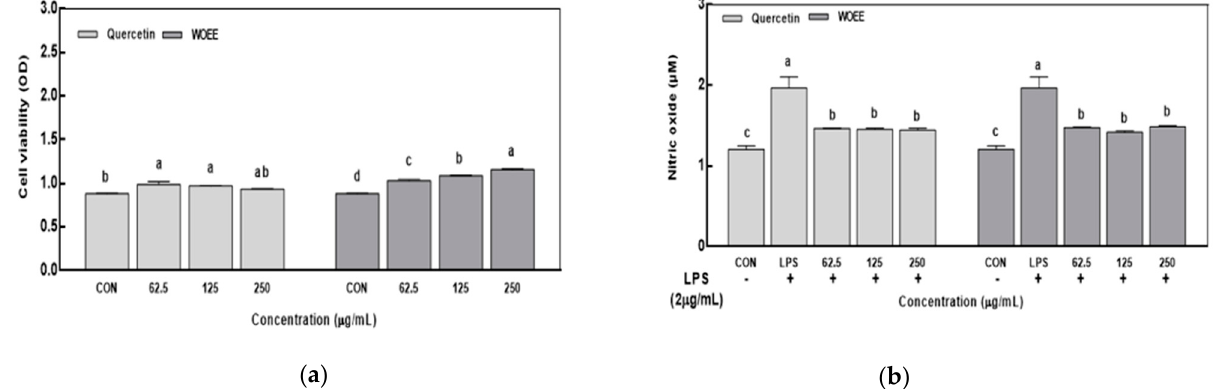
Figure 3. Cell viability of RAW 264.7 macrophages ( a ) and nitric oxide (NO) production by RAW 264.7 macrophages ( b ) of quercetin and WOEE depending on concentration. The data were analyzed by one-way ANOVA using SPSS software and each bar presents the mean ± SE. (n = 3). a–d Mean values with different letters are significantly different ( p < 0.05) among groups, determined by Duncan’s multiple range test.